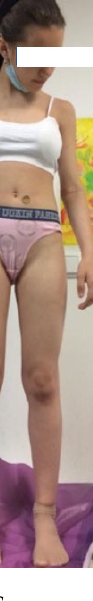
Figure 5. Case report 5: 11-year-old girl with height − 1.41 SD, MPH − 1.03 SD, and tested negative for SHOX deletion.